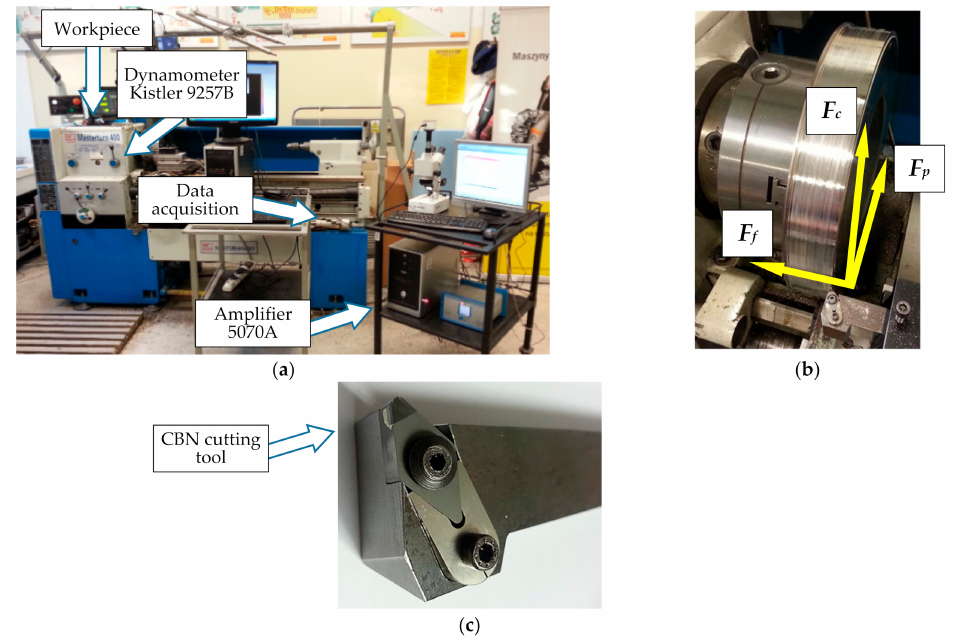
Figure 3. Test bench ( a ), fastening of the workpiece ( b ), and cutting tool with cubic boron nitride (CBN) insert ( c ).